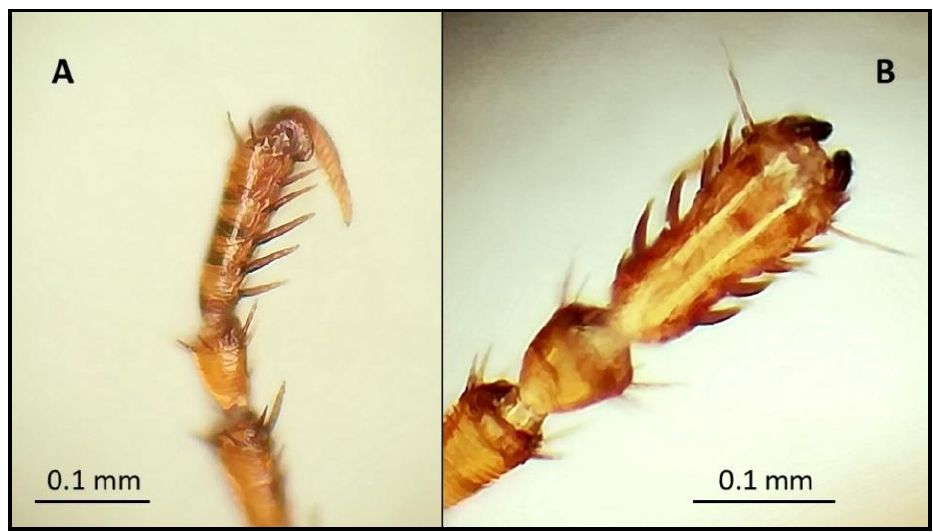
Figure 3. Last article of all tarsi with 5 pairs of lateral plantar bristles ( A ) side view and ( B ) front view).